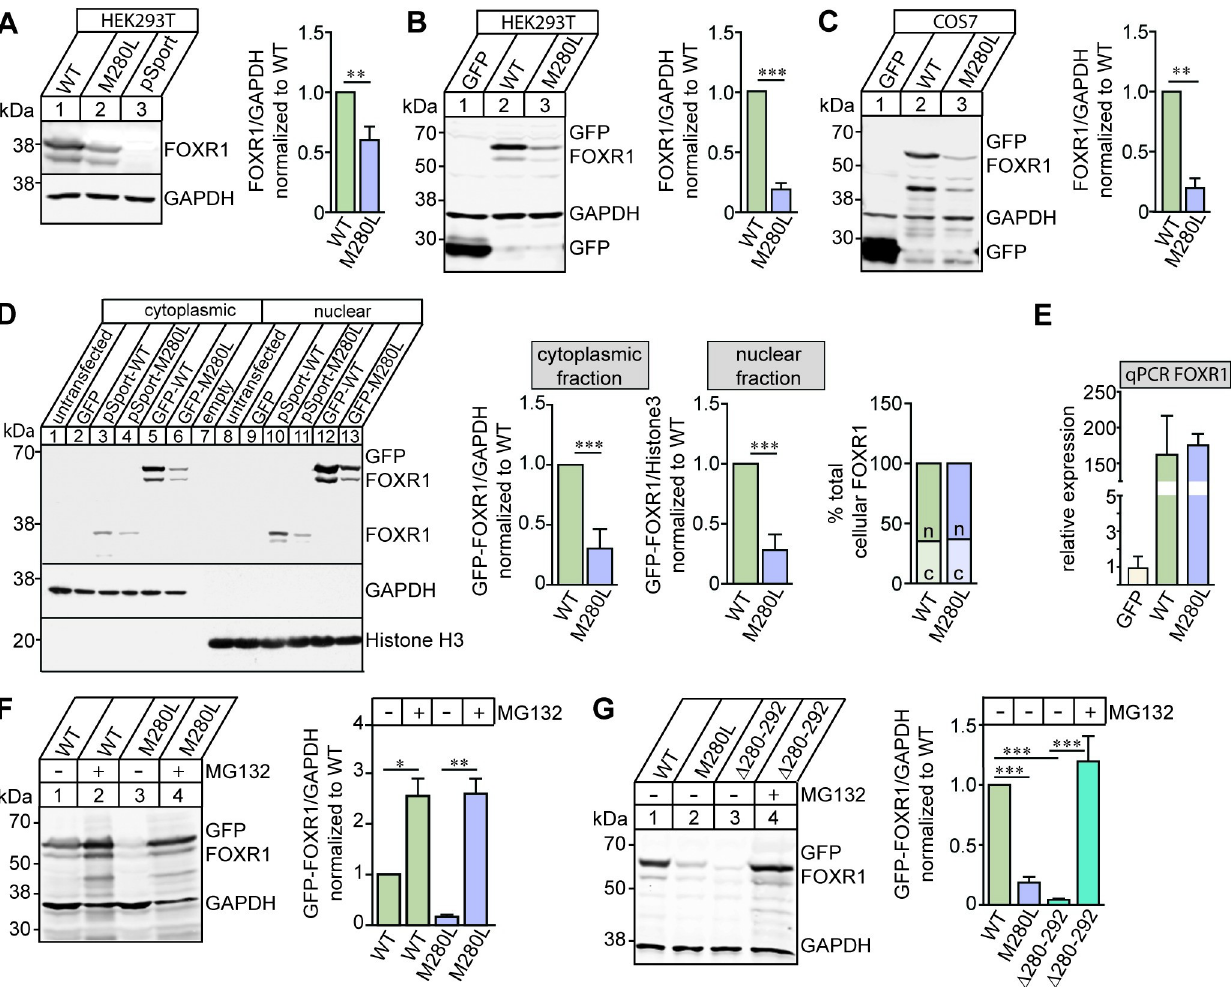
Fig 2. The M280L mutant destabilizes FOXR1 protein. (A) Representative immunoblots and quantitative analysis of FOXR1 from HEK293T cells transfected with pCMV-SPORT6 human FOXR1 WT or M280L mutant. GAPDH served as a loading control. Graph represents FOXR1 over GAPDH normalized to WT. Unpaired t -test (n = 4 independent experiments, �� p = 0.0025). (B) Representative immunoblot and quantitative analysis of FOXR1 from HEK293T cells transfected with GFP, GFP-tagged human FOXR1 WT or M280L mutant. GAPDH served as a loading control. Graph represents FOXR1 over GAPDH normalized to WT. Unpaired t -test (n = 5 independent experiments, ��� p < 0.0001). (C) Representative immunoblot and quantitative analysis of FOXR1 from COS7 cells transfected with GFP, GFP-tagged human FOXR1 WT or M280L mutant. GAPDH served as a loading control. Graph represents FOXR1 over GAPDH normalized to WT. Unpaired t -test (n = 4 independent experiments, �� p = 0.0013). (D) Representative immunoblots and quantitative analysis of cytoplasmic (c) and nuclear (n) fractions of FOXR1 from HEK293T cells transfected with pCMV-SPORT6 or GFP-tagged human FOXR1 WT or M280L. GAPDH and Histone H3 served as cytoplasmic and nuclear loading markers, respectively. Graph represents FOXR1 over GAPDH normalized to WT. Unpaired t -test (n = 5 independent experiments, ��� p < 0.0001). The percentages of total cellular FOXR1 in the cytoplasmic and nuclear fractions were determined. (E) Quantitative PCR (qPCR) to quantify FOXR1 mRNA levels from HEK293T cells transfected with GFP, GFP-tagged human FOXR1 WT or M280L mutant. Graph represents relative FOXR1 mRNA expression normalized to GFP. One-way ANOVA Tukey’s multiple comparisons test (n = 3 independent experiments). (F) Representative immunoblot and quantitative analysis of FOXR1 from HEK293T cells transfected with GFP-tagged human FOXR1 WT or M280L mutant. Protein stability was monitored by quantitative immunoblotting after blocking with proteasome inhibitor MG132. Graph represents FOXR1 over GAPDH normalized to untreated WT. One-way ANOVA Tukey’s multiple comparisons test (n = 3 independent experiments, � p = 0.0245, �� p = 0.0003). (G) Representative immunoblot and quantitative analysis of FOXR1 from HEK293T cells transfected with GFP-tagged human FOXR1 WT, M280L mutant or FOXR1 C-terminal truncation mutant lacking the last 12 amino acids ( Δ 280–292). Protein stability was monitored for FOXR1 Δ 280–292mutant by blocking proteasome degradation with MG132. GAPDH served as a loading control. Graph represents FOXR1 over GAPDH normalized to untreated WT. One-way ANOVA Tukey’s multiple comparisons test (n = 3 independent experiments, ��� p < 0.0001).